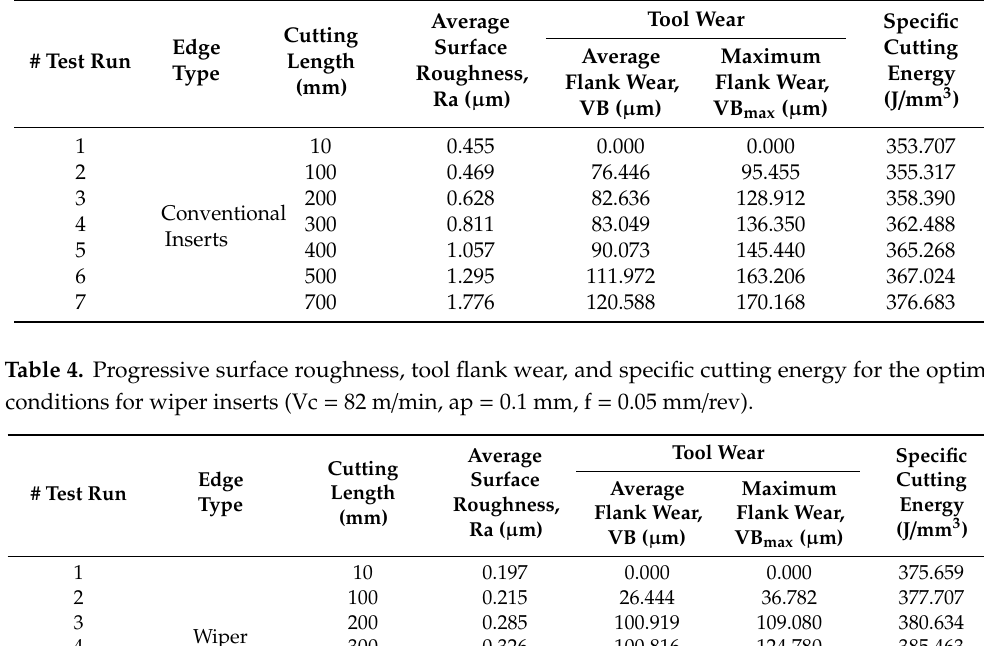
Table 3. Progressive surface roughness, tool flank wear, and specific cutting energy for the optimal